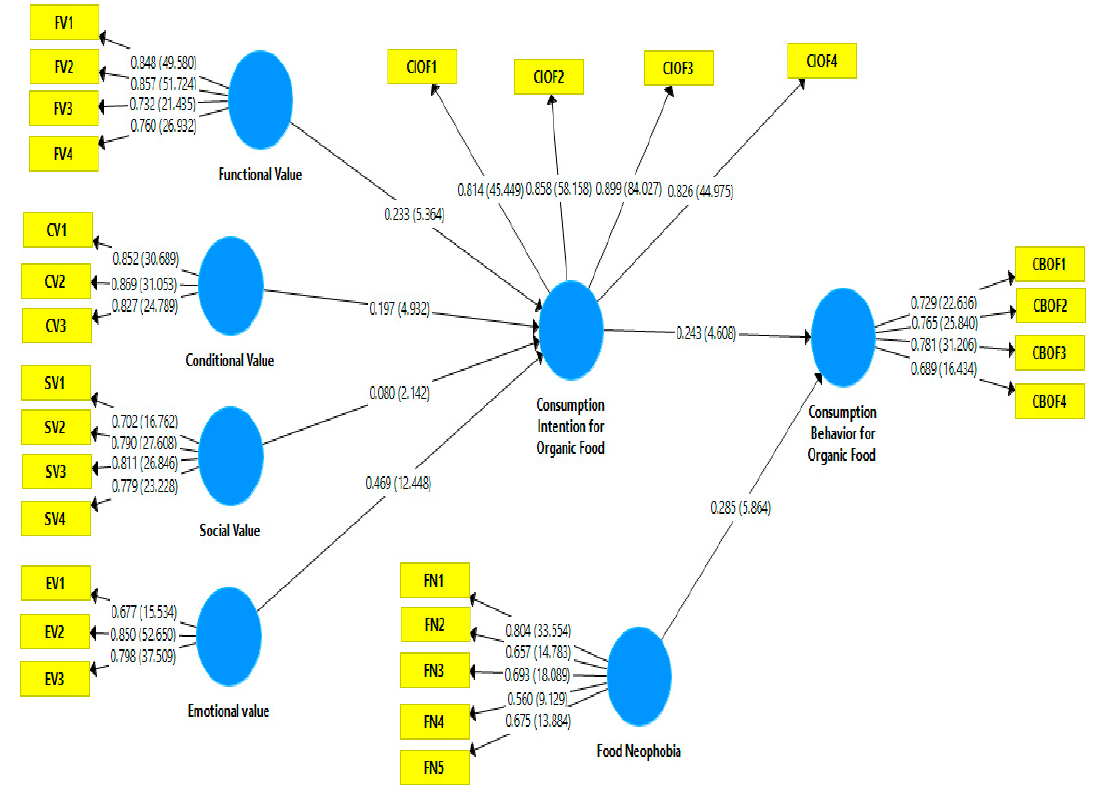
Figure 2. Structural model evaluation (Bootstrap)